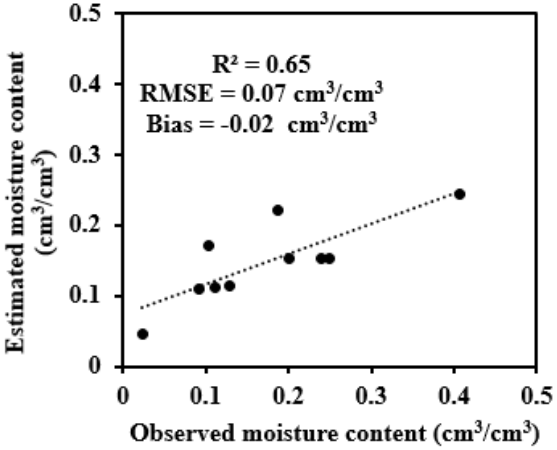
Figure 5. Scatter plot of observed soil moisture, for the soil moisture measurement sites in the Reynolds Creek Experimental Watershed as shown in Figure 1, with SERVES estimated in the month of September 2014.